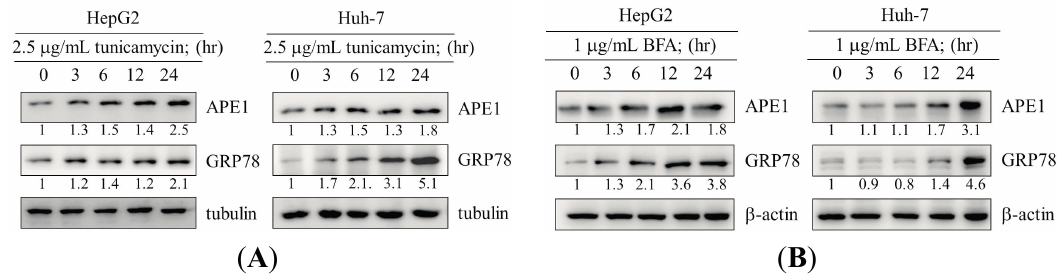
Figure 1. Elevated expression of APE1 in response to endoplasmic reticulum stress. ( A ) and ( B ) present the time- dependent effect of ER stress inducer, tunicamycin and brefeldin A, on APE1 expression. HepG2 and Hun-7 Cells were exposed to tunicamycin and brefeldin A in 10% FBS-supplemented DMEM for the times indicated. The cell lysates were analyzed by western blotting with antibodies for APE1, GRP78, tubulin, and β -actin. The expression levels of APE1 and GRP78 were quantified by using ImageJ software (National Institutes of Health, Bethesda, MD, USA).